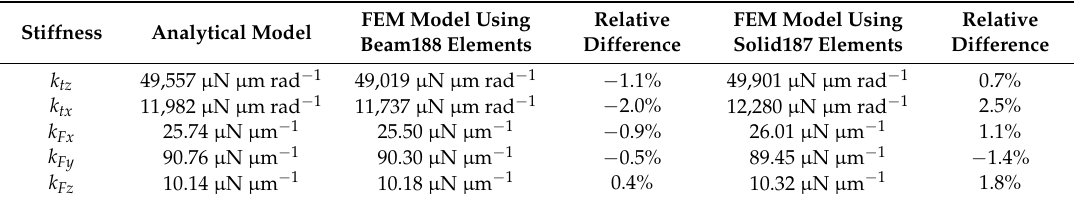
Figure 15. FEM model of the serpentine springs using beam188 elements of ANSYS software. Table 2. Stiffness values of the serpentine springs of the microgripper.